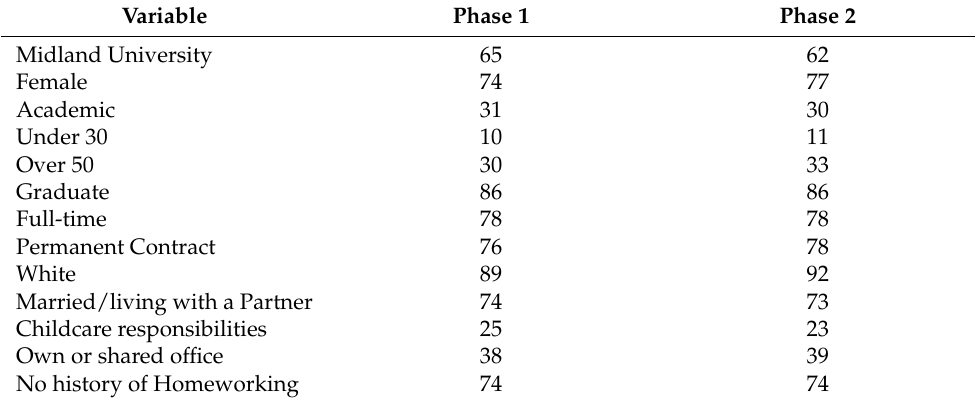
Table 1. Characteristics of the Sample: Percentages with characteristics by